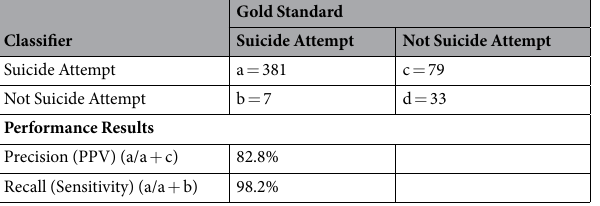
Table 2. Classifier Performance Results for Suicide Attempt after Post-Processing (n =